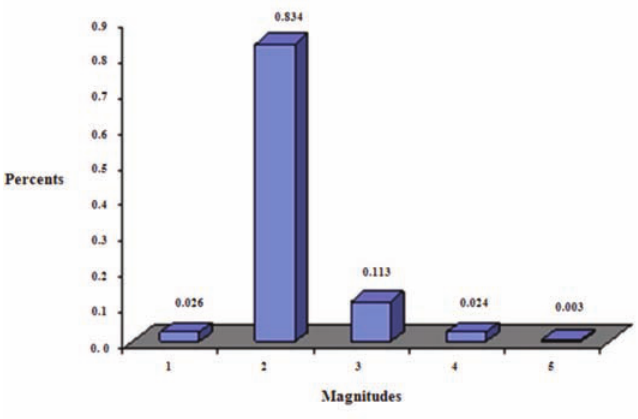
Figure 7. The percentage of occurrences in each class of magnitudes [from Sadeghian and Jalali-Naini